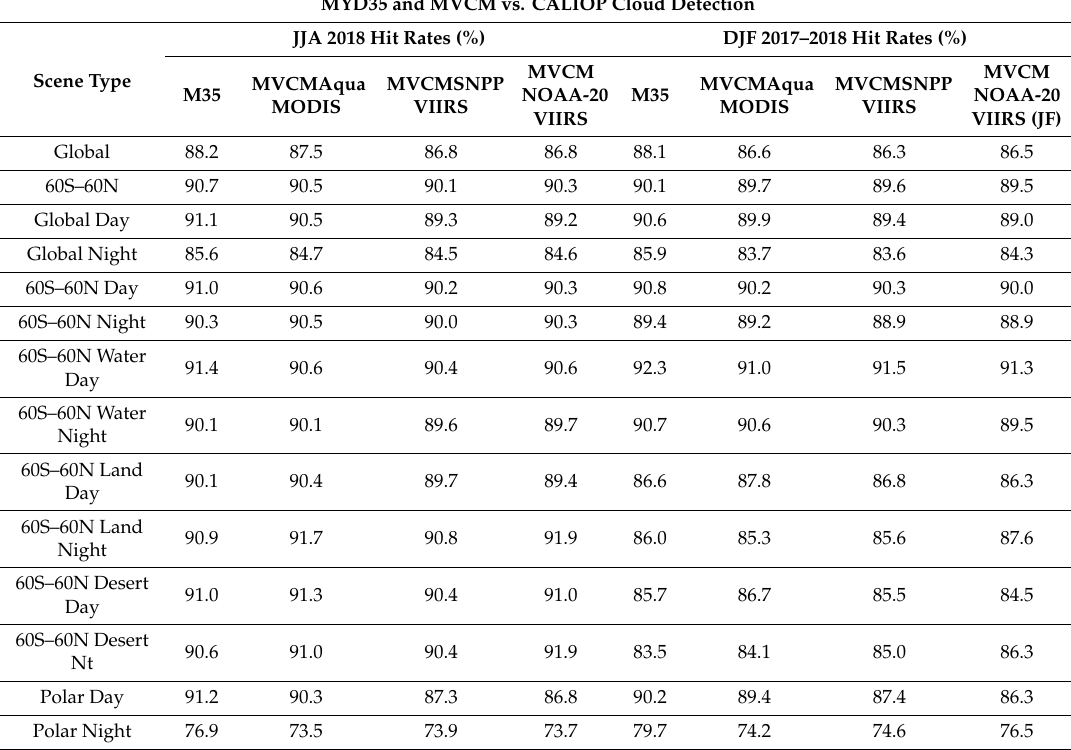
Table 3. Cloud detection hit rates of MYD35 and MVCM compared to the Cloud-Aerosol LIdar with Orthogonal Polarization (CALIOP)